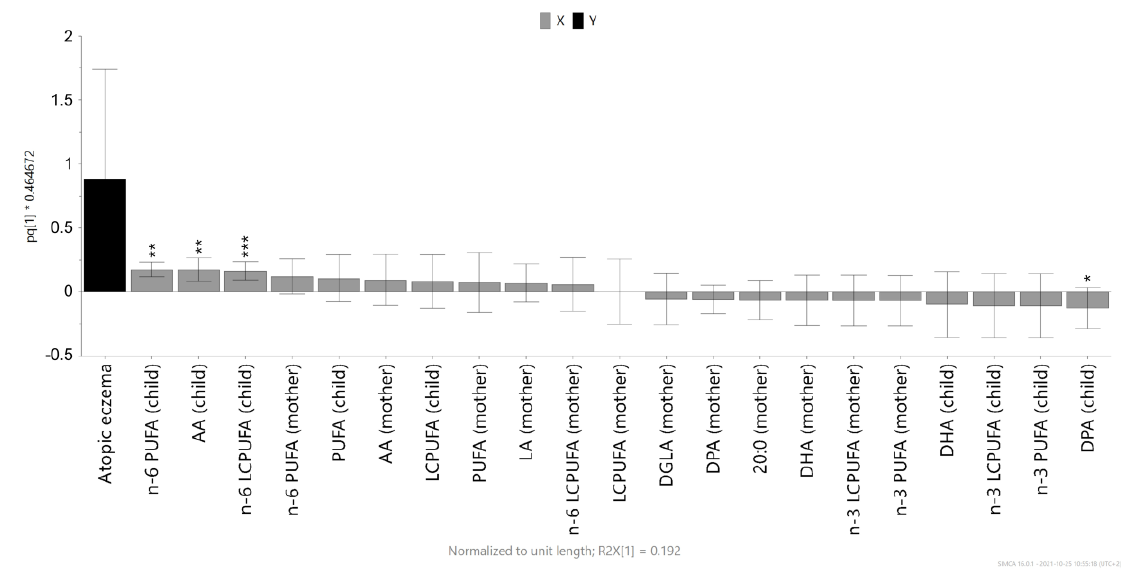
Figure 3. Orthogonal partial least squares (OPLS) loading column plot showing the associations between atopic eczema at 12 months of age and the proportion of selected fatty acids in maternal and infant cord plasma phospholipids. Fatty acids with a variable of importance (VIP) value >0.8 in the model that included all fatty acids (shown in Supplementary Figure S1) are included here. Associations that were significant in the univariate analyses (Mann–Whitney U -test) are indicated with an asterisk: * p < 0.05, ** p < 0.01, *** p < 0.001. Abbreviations: AA, arachidonic acid (20:4 n-6); DGLA, dihomo-gamma-linoleic acid (20:3 n-6); DHA, docosahexaenoic acid (22:6 n-3); DPA, docosapentaenoic acid (22:5 n-3); LCPUFA, long-chain PUFA; PUFA, polyunsaturated fatty